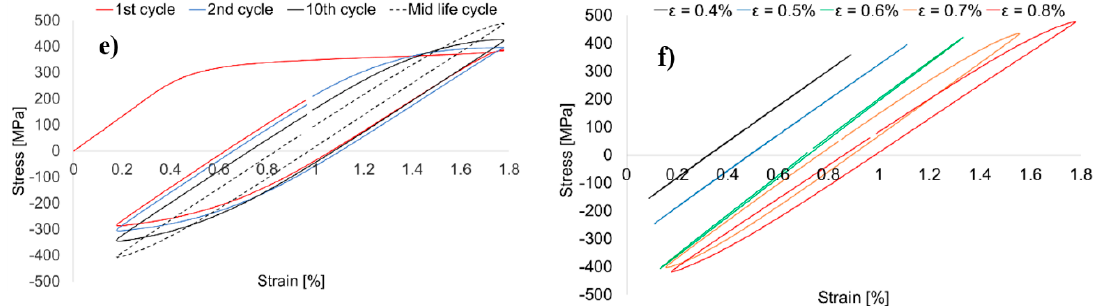
Figure 6. Stress-strain loops of sample tested with ε = 0.4% ( a ), ε = 0.5% ( b ), ε = 0.6% ( c ), ε = 0.7% ( d ), ε = 0.8% ( e ), and the comparison of mid-life loops of the samples ( f ).